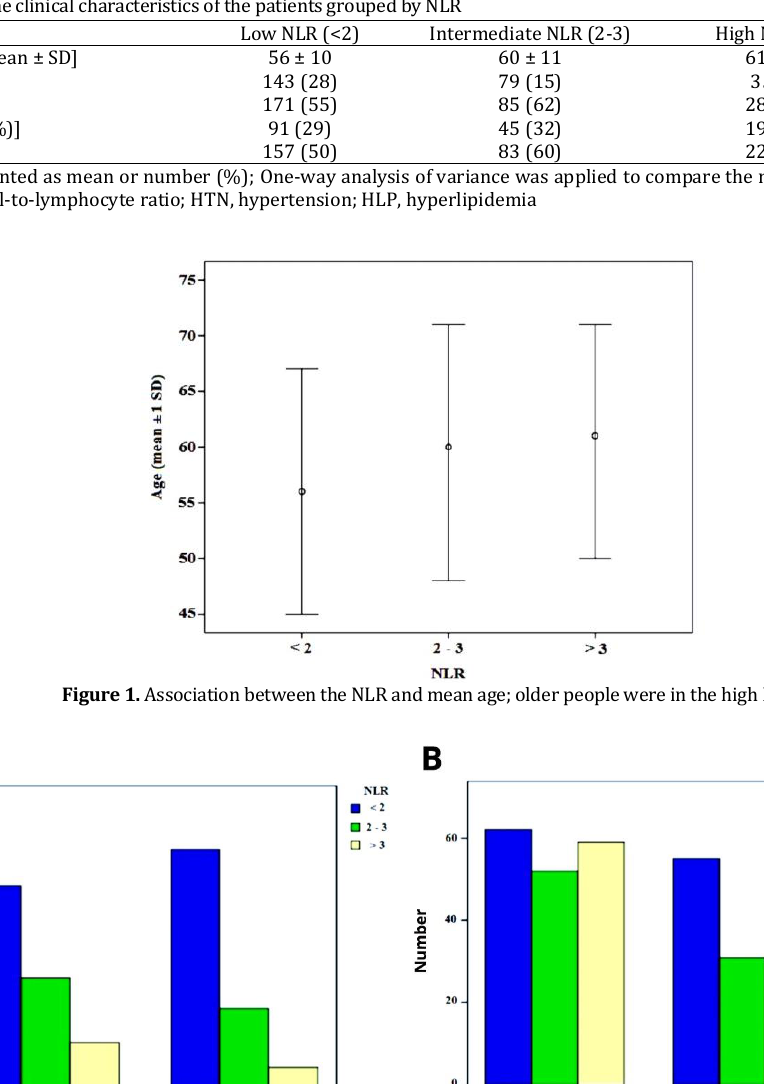
Table 1. Baseline clinical characteristics of the patients grouped by NLR Variables